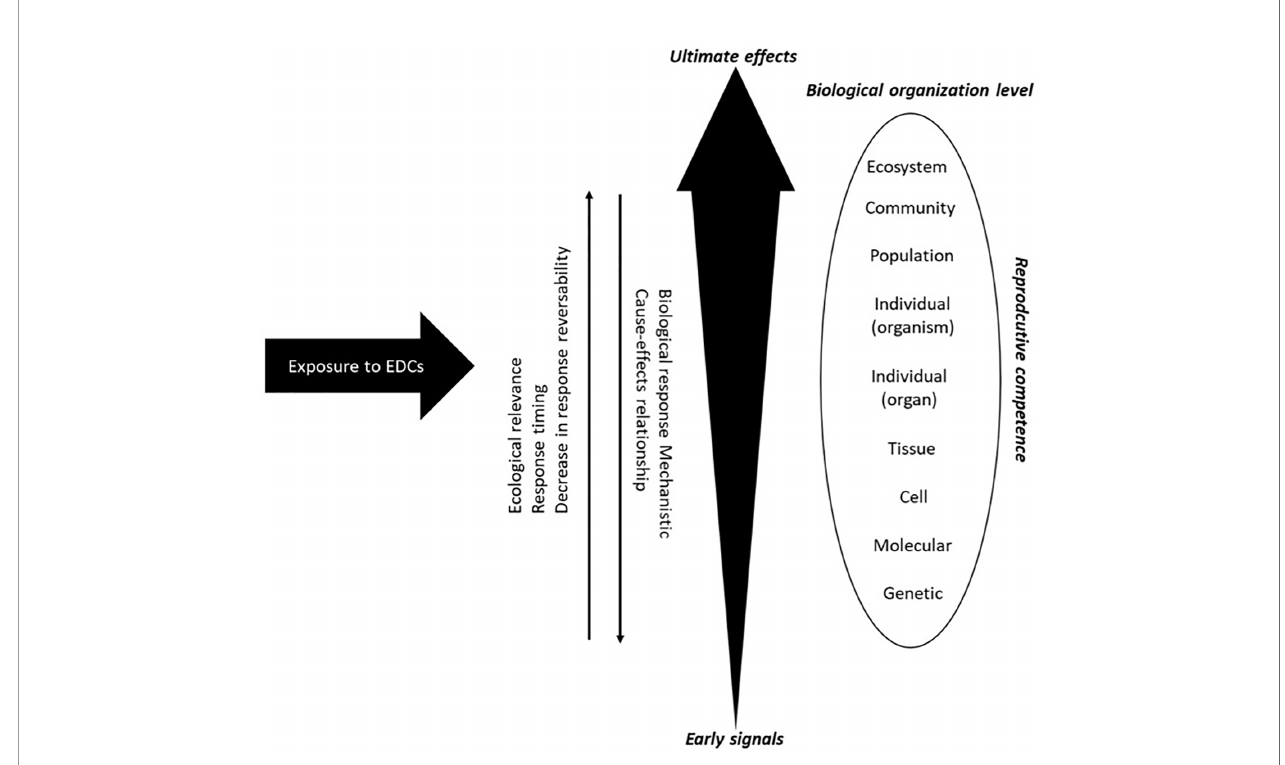
FIGURE 2 | Schematic representation of stress responses within a biological system (Modi fi ed from 21,